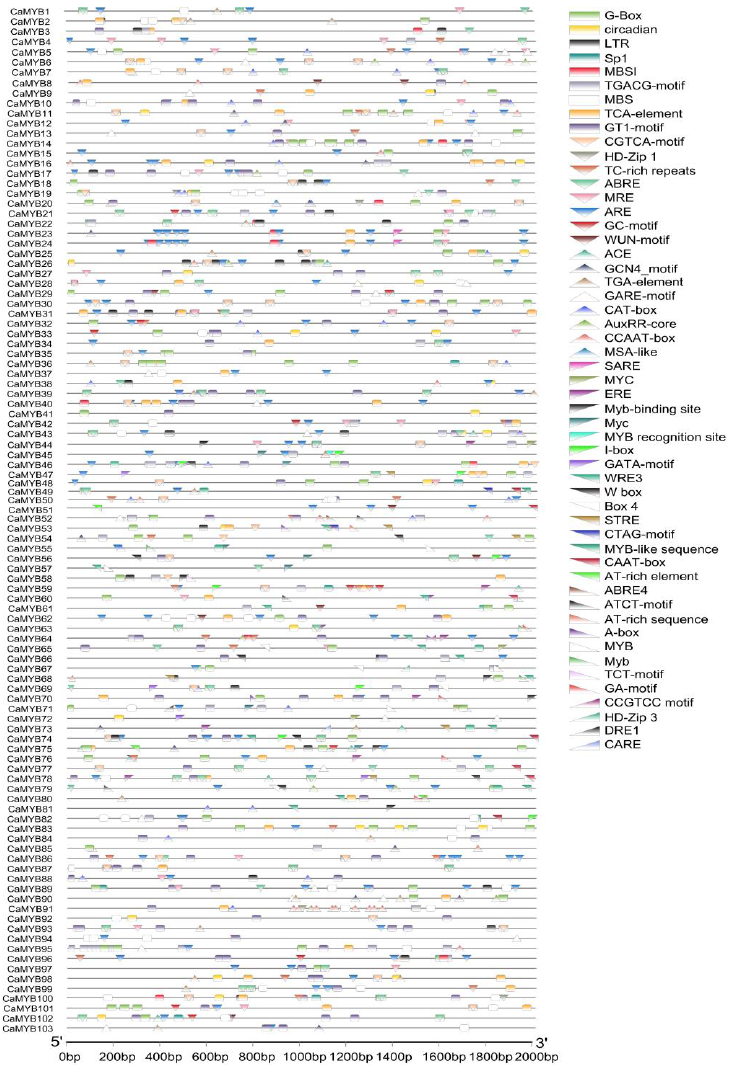
Figure 4. cis -Element analysis of CaMYB-related family. Different shapes and colors represent different elements.